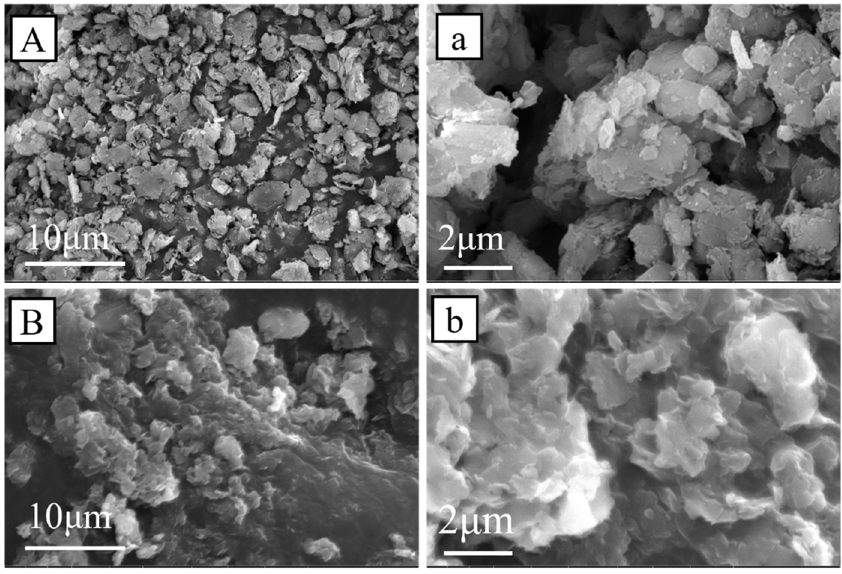
Figure 8. SEM images of CaMMT ( A , a ) and TCPP-CaMMT-2/1 ( B , b ).